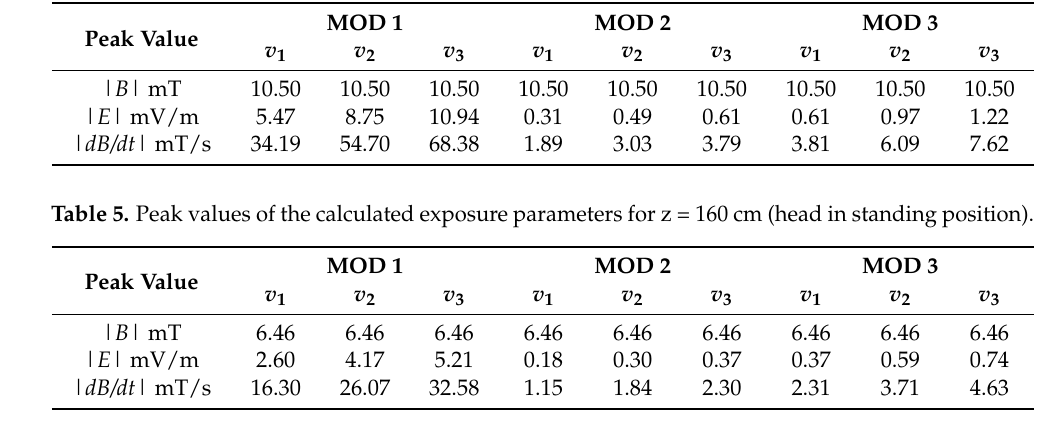
Figure 3. The calculated induced electric field | E | (in mV/m) in the body of a worker walking along a linear trajectory parallel to the x -axis, where x = 0 m corresponds to a point near the spectrometer and x = 2.7 m is the location of the console: ( a ) walking speed model MOD1, from NMR to console; ( b ) walking speed model MOD2, from NMR to console; ( c ) walking speed model MOD3, from NMR to console; ( d ) walking speed model MOD2, from console to NMR. All the results are for v max = 2 m/s. Table 4. Peak values of the calculated exposure parameters for z = 120 cm (thorax–heart in standing position).